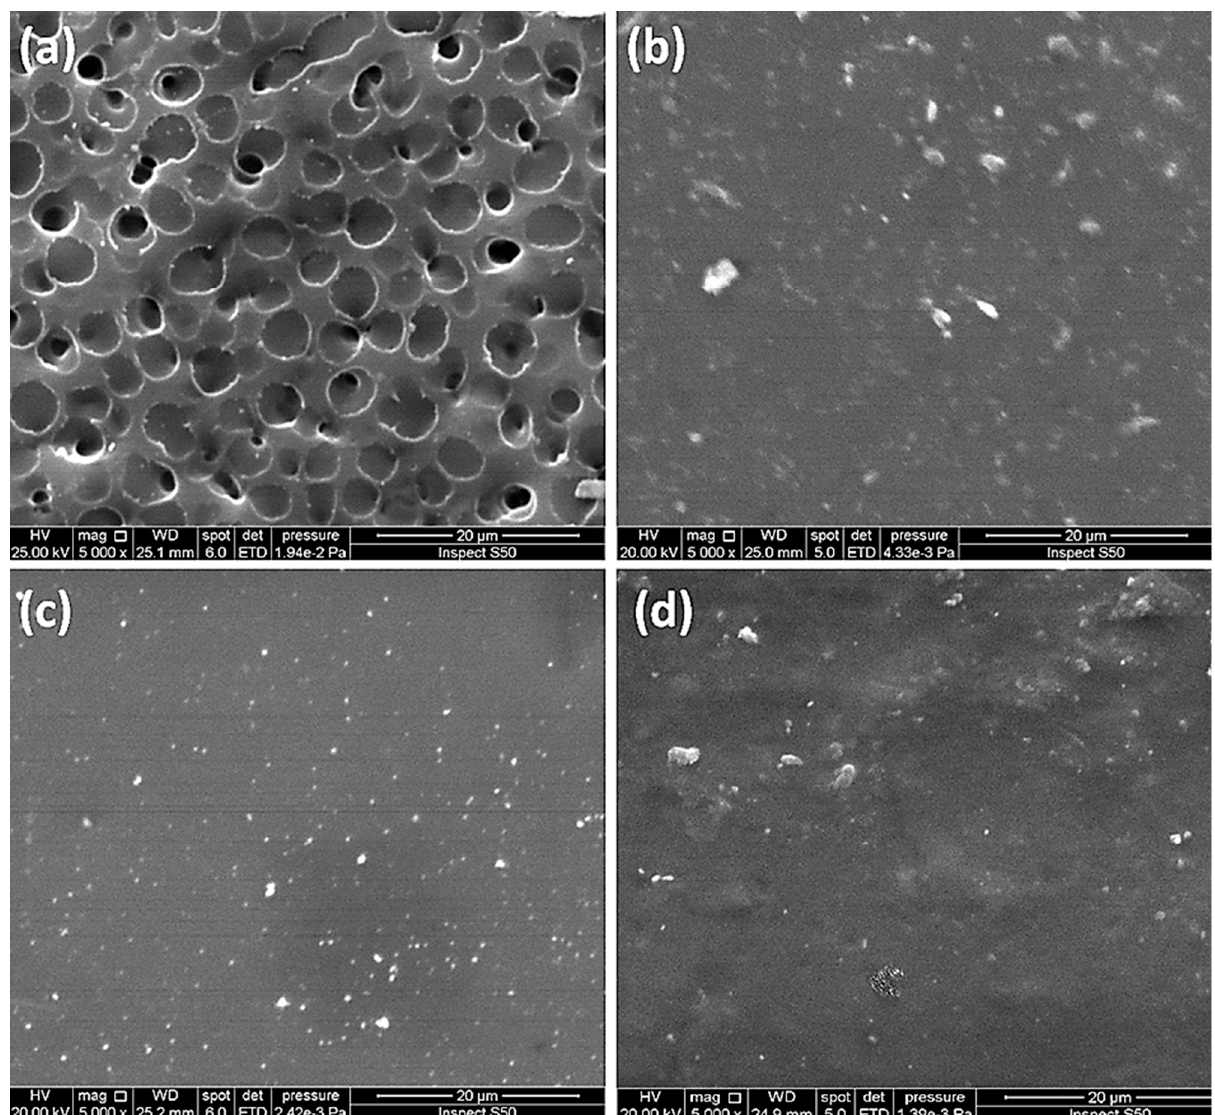
Figure 6. SEM images of irradiated ( a ) pure PVC, ( b ) PVC + 1 , ( c ) PVC + 2 , and ( d ) PVC + 3 .